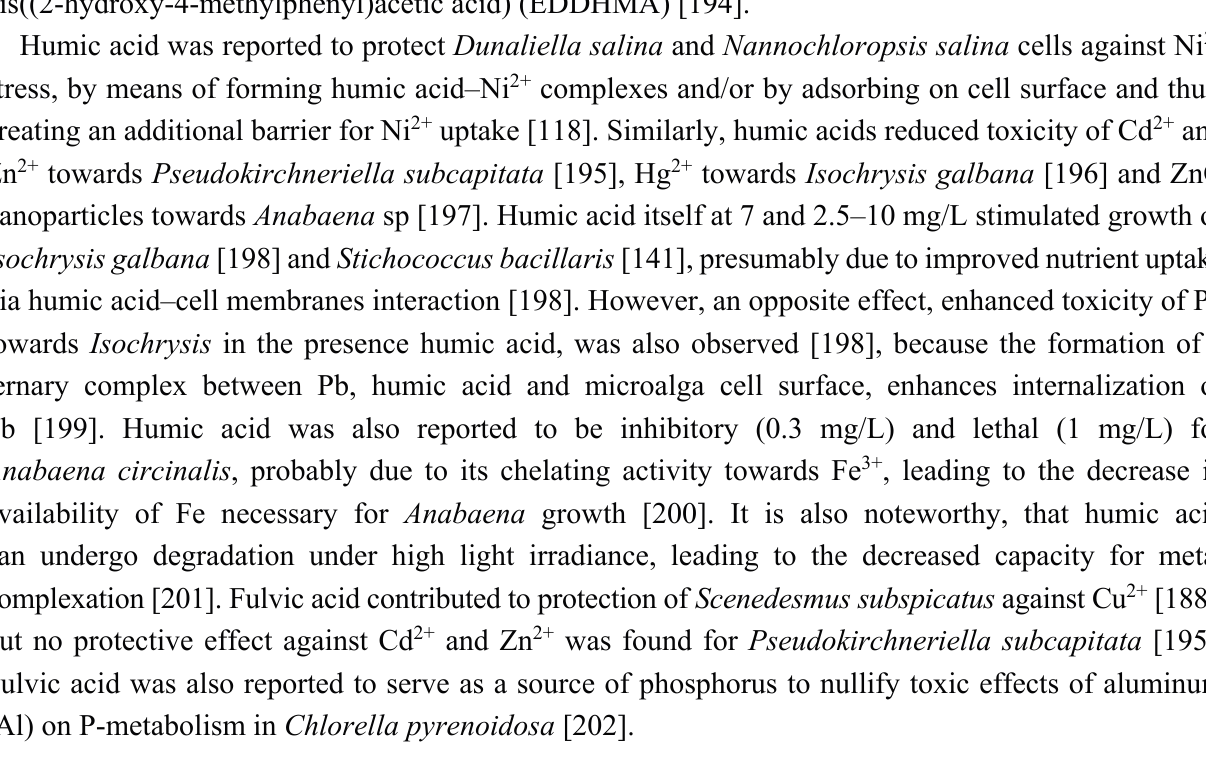
Table 5. Effect of humic and fulvic acids on microalgae response towards